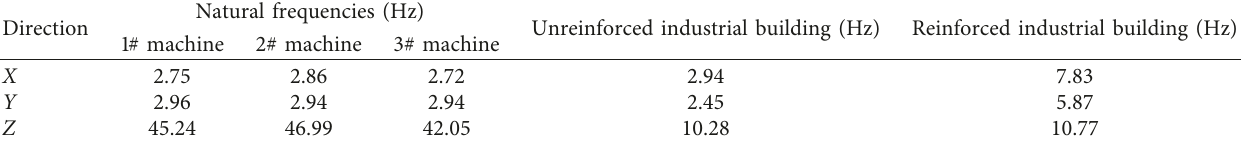
Table 3: Natural frequencies comparison before and after reinforcement.